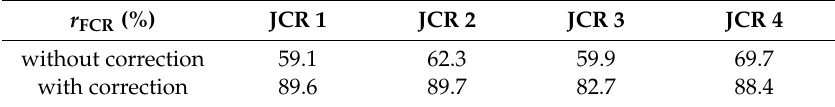
Table 3. Faults classification rate with different joint confidence region (JCR) profiles.